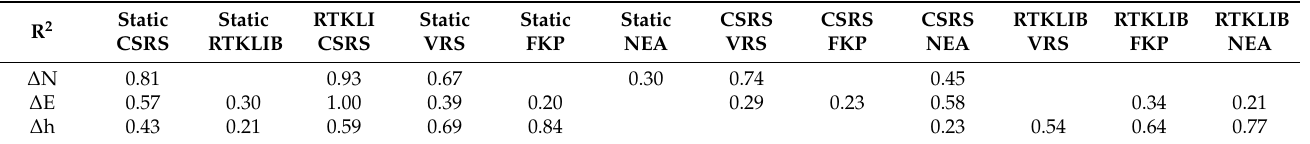
reported in grey, very weak and weak correlations (r 2 < 0.15) were